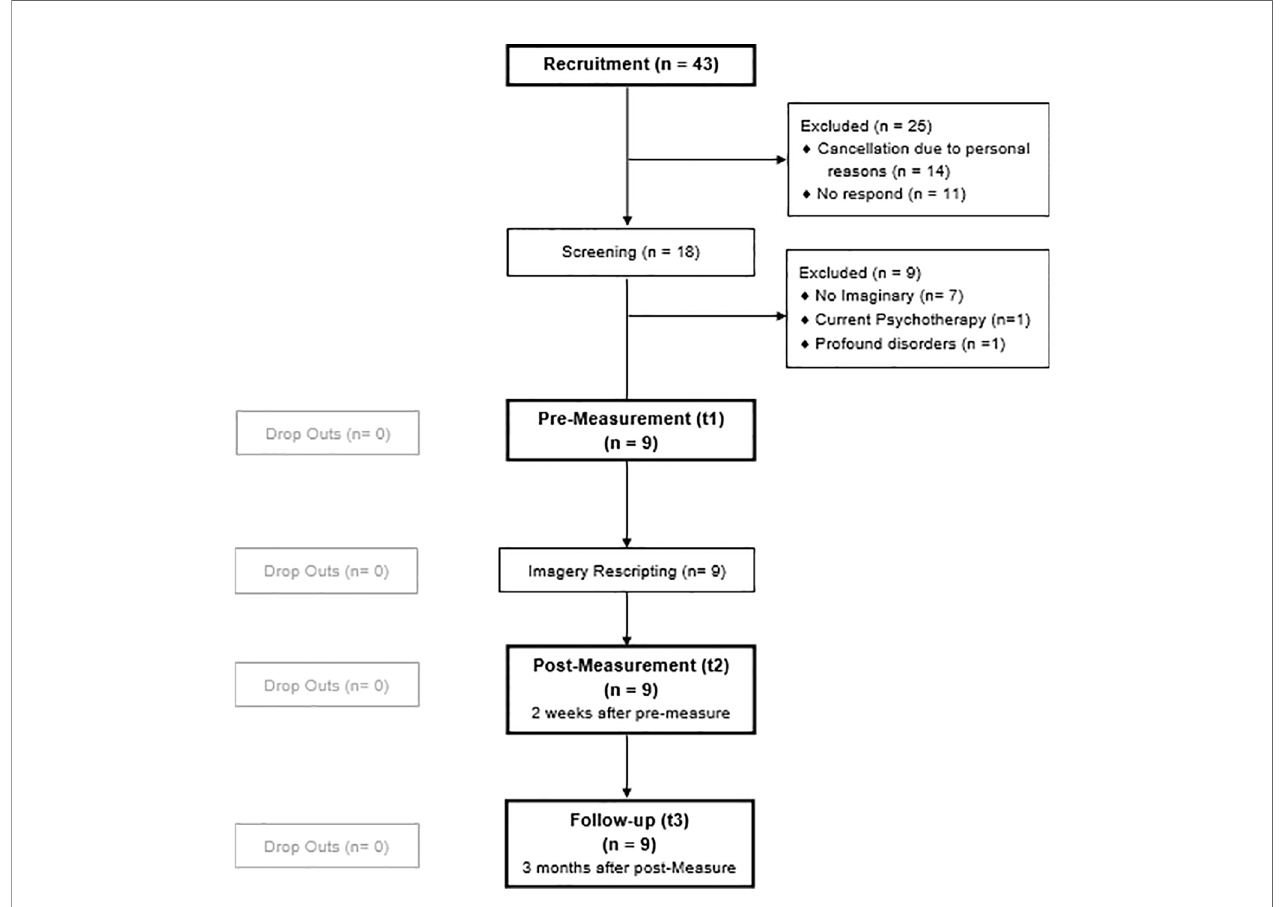
FIGURE 1 | Participants fl ow